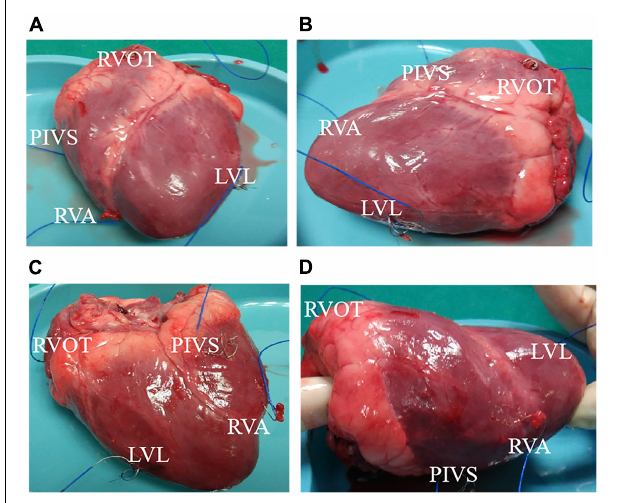
FIGURE 1 | The position of the pacemaker lead in the heart. (A) Front view of heart. (B) Left side view of heart. (C) Back view of heart. (D) Right side view of heart. RVA, right ventricular apex; PIVS, posterior interventricular septum; RVOT, right ventricular outflow tract; LVL, left ventricular lateral